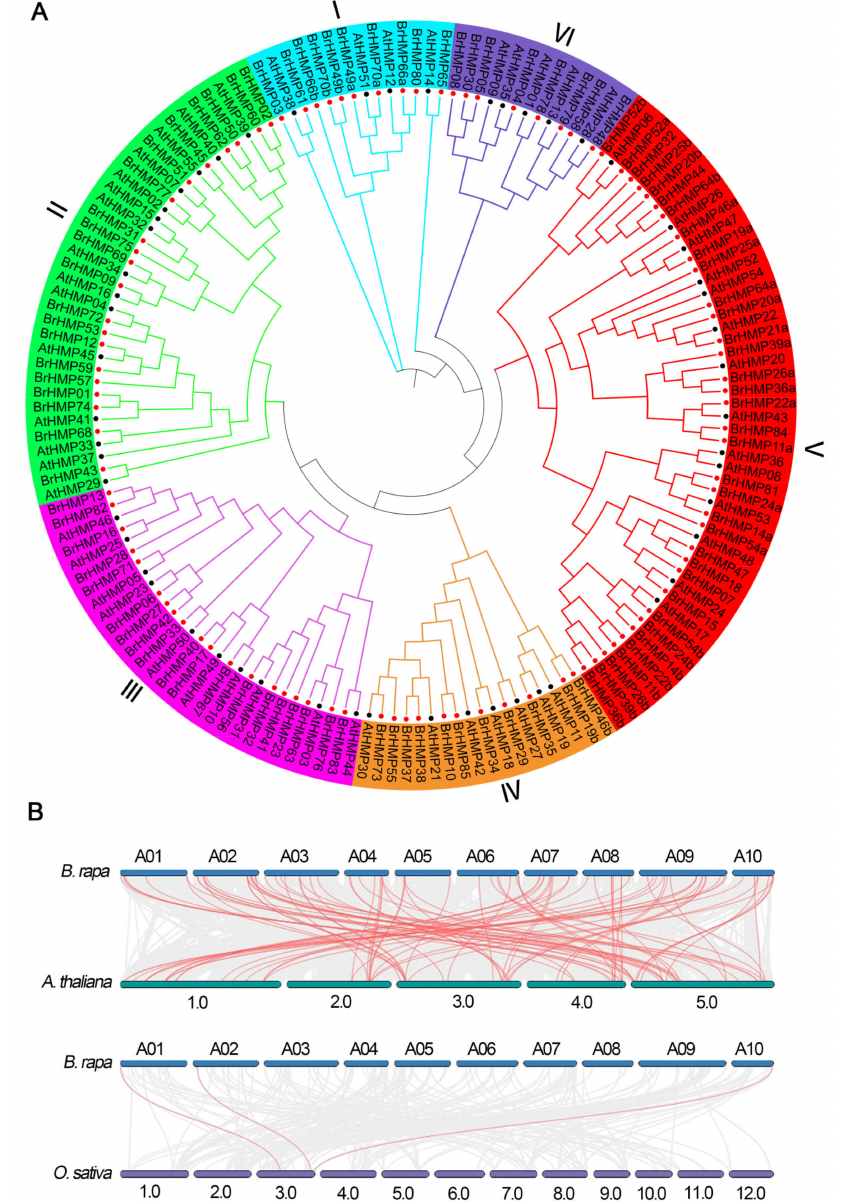
Figure 2. Phylogenetic tree and collinearity analysis of BrHMPs . ( A ) Phylogenetic tree of the HMPs. ( B ) Collinearity analysis of HMP genes in B. rapa , A. thaliana , and O. sativa . Homologous HMP gene pairs between species are linked by red